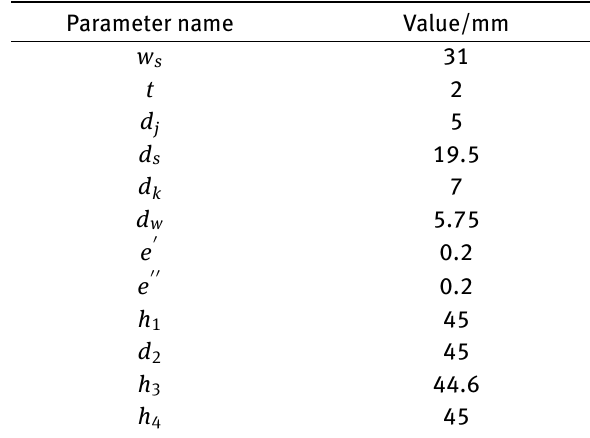
Table 2: Geometric and mechanical parameters of studied MT-T